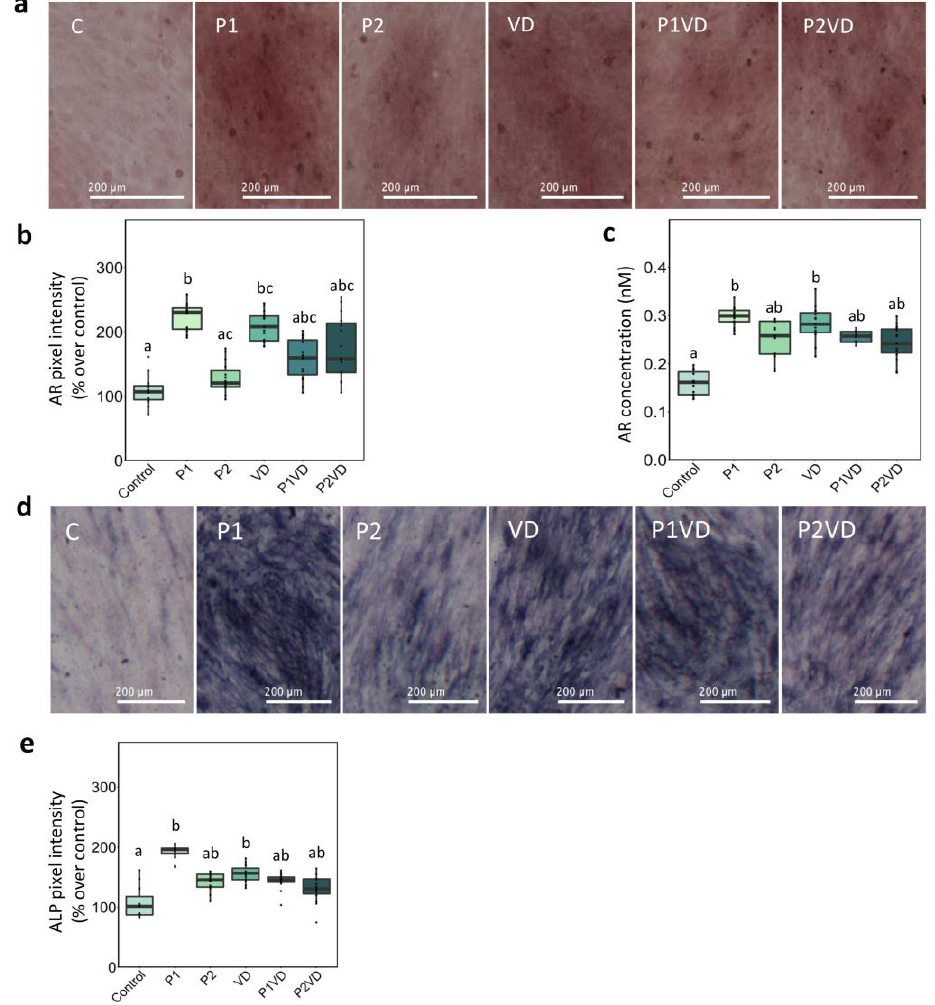
Figure 2. Staining of the hFOB1.19 cells cultured in the different treatments—cultured without any treatment (Control), treated with VD (VD), with two probiotics (P1 and P2) and their respective combinations with VD (P1VD and P2VD): ( a ) Representative images of the different treatments applied to hFOB1.19 cells for 7 days after AR staining, Scale bar: 200 µm; ( b ) AR pixel intensity measured using ImageJ and converted to % values over control; ( c ) Quantitative analysis of the AR concentration indicative of the ECM mineralization following the different treatments by measuring the absorbance using spectroscopy; ( d ) Representative images of the different treatments applied to hFOB1.19 cells for 7 days after ALP staining, Scale bar: 200 µm; ( e ) ALP pixel intensity measured using ImageJ and converted to % values over control. The graphs show the mean and standard deviation as error bars. One-way ANOVA was used to analyze the difference between the groups and Tukey’s post hoc test was used for multiple comparisons among groups. Data are shown as means ± SD as error bars. Different letters above each column denote statistically significant differences among experimental groups ( n = 5, p < 0.05). Three groups that differ significantly from each other are labelled a, b, and c, and two that differ from each other but not from the third are labelled a, b, and ab. ALP cytochemical staining of the hFOB1.19 cells was used to quantify the osteogenic differentiation in the cells. Both P1 and VD induced a significant increase in ALP